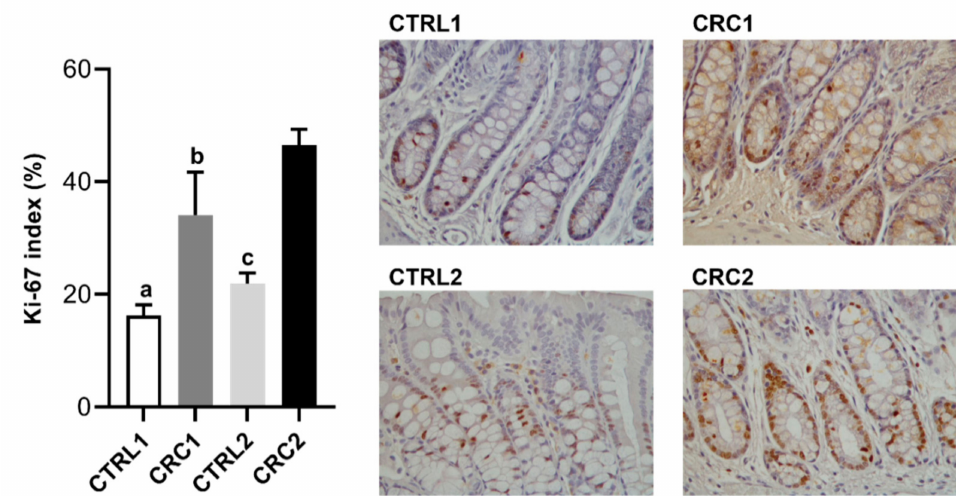
Figure 5. Ki-67 immunoexpression in rat’s colon. At left, Ki-67 index (percentage) observed in the CTRL and CRC groups. Data are presented as mean ± SD. a Statistically different from CRC1 group ( p < 0.001); Statistically different from CRC2 group ( p < 0.001); b Statistically different from CTRL2 group ( p < 0.01); Statistically different from CRC2 group ( p < 0.01); c Statistically different from CRC2 group ( p < 0.001). On the right, representative histological images of Ki-67 immunolabelling of rat’s colon, with Ki-67 labeled epithelial cells showing brown nuclear positivity (Gill’s hematoxylin, 400 × ). The control groups (CTRL1 and CTRL2) were injected with EDTA–saline solutions and the CRC groups (CRC1 and CRC2) were injected with DMH. Groups 1 and 2 were euthanized 11 and 17 weeks after the first administration, respectively.